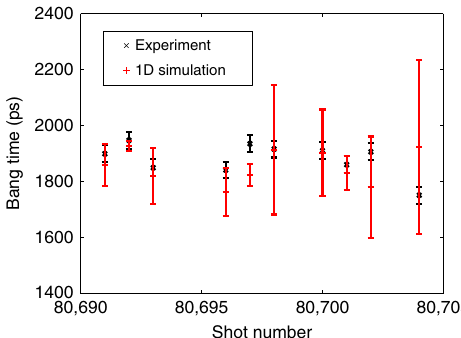
Fig. 2 Comparison of simulated and experimental bang times. Bang times (time of peak neutron production) for all ten capsule implosions compared to 1D simulation results. 1D simulations account for variations in HT fi ll pressure, as-shot laser power history, and capsule ablator thickness. The simulation error bars indicate the effect of measured ablator thickness variances, which ranged from 0.5 to 8.7 μ m; the average ablator thickness varied from 22.0 to 26.2 μ m. The simulated error bars were calculated based on the standard deviation of 1D simulations performed at the extremes of measured ablator thickness and ablator thickness variances. The experimental bang times were determined from a neutron temporal diagnostic and the error is based on the response time of this instrument 61